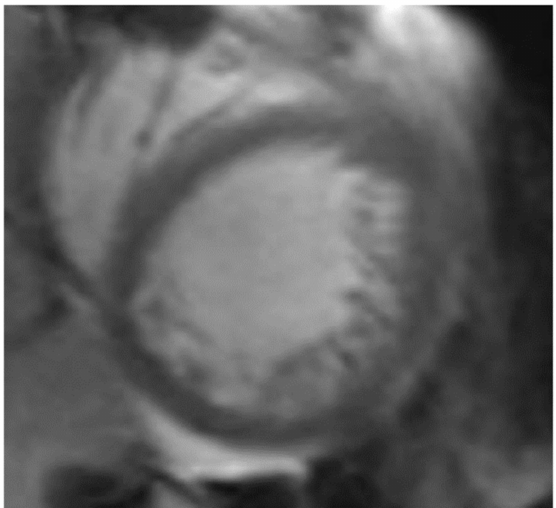
Figure 3. Magnetic resonance imaging: short axis of the left ventricle with excessive trabeculations. Notable, the septum shows no